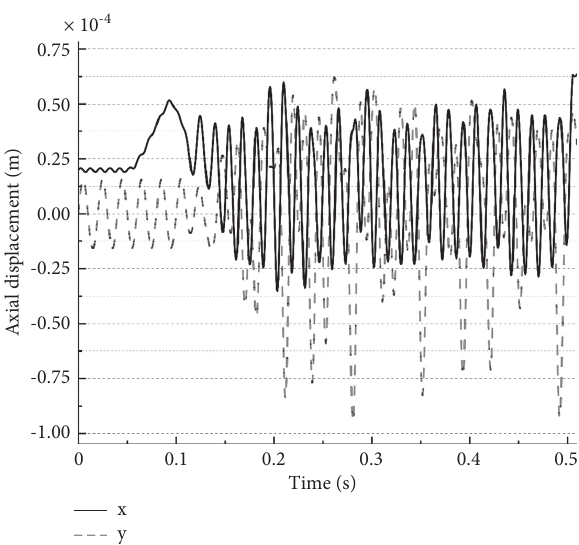
Figure 24: X- and Y -axis vibration displacement time-domain